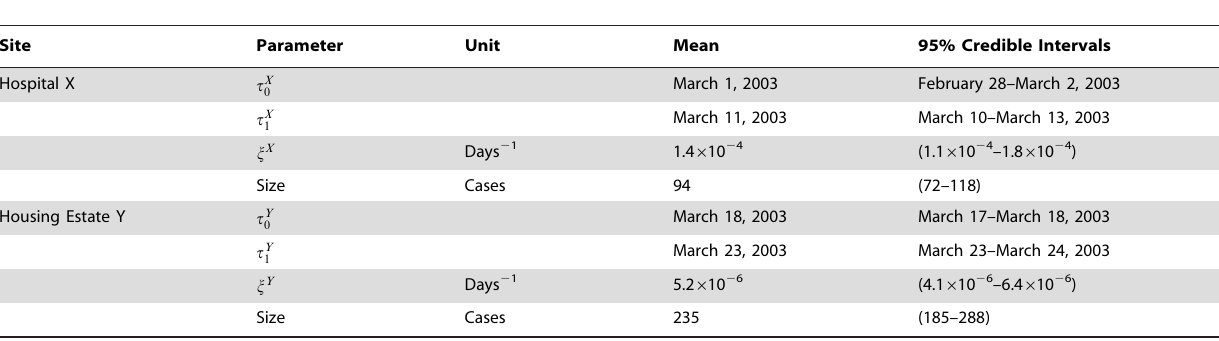
Table 2. Estimated Parameters for Super Spreading Events in Hospital X and Housing Estate Y.